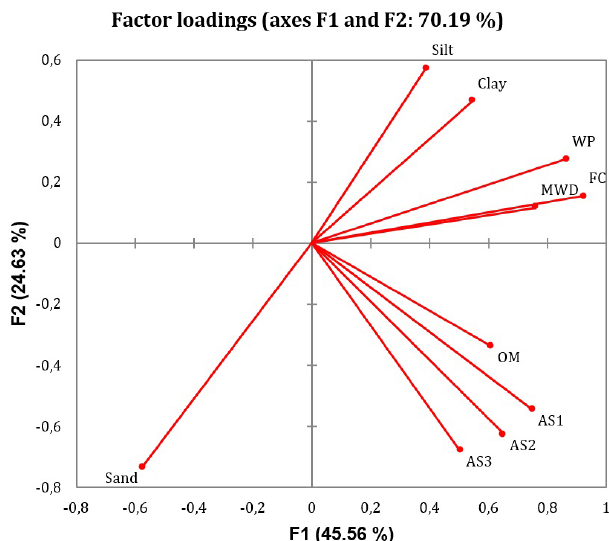
Figure 5. Factor analysis of studied soil properties in the Batumi delta (MWD, mean weight diameter; OM, organic matter content; AS 1 , aggregate stability of 1.00–2.00mm aggregate size; AS 2 , ag- gregate stability of 0.50–1.00mm aggregate size; AS 3 , aggregate stability of 0.25–0.50mm aggregate size; FC, water retention in − 33kPa; WP, water retention in − 1500kPa).